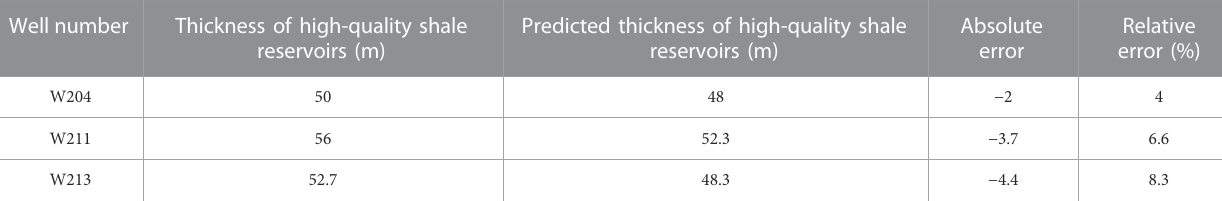
TABLE 4 Statistical table of the prediction error of high-quality shale reservoir thickness. Well number